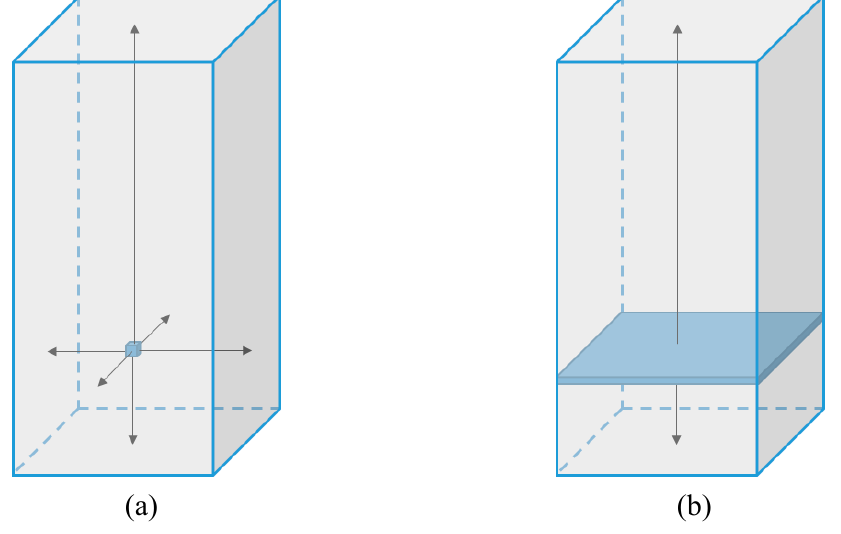
Figure 29. Distances to the wall in Cell Level ( a ) and in the Layer Level ( b ).